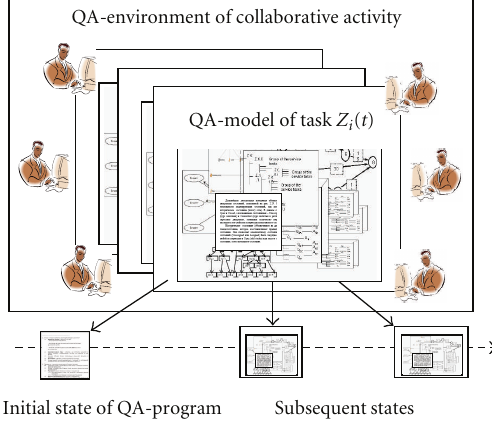
Figure 11: Form of existing of the programmed